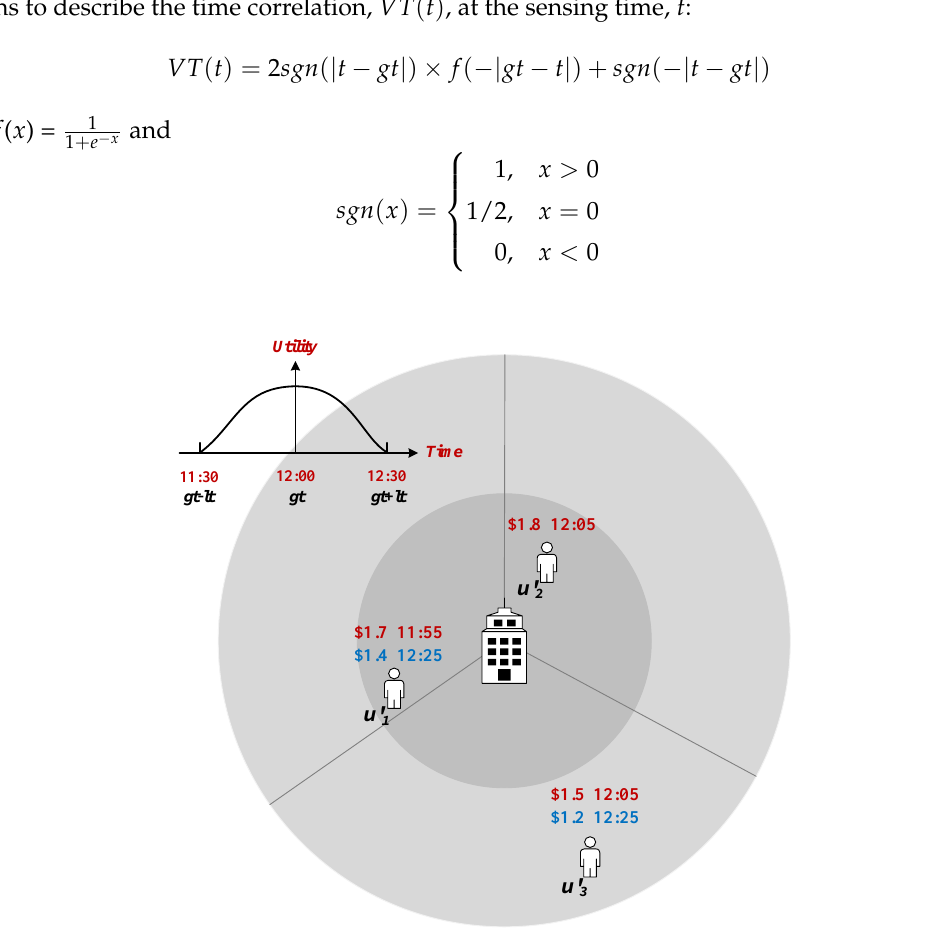
Figure 6. Data utility decided by different sensing times and